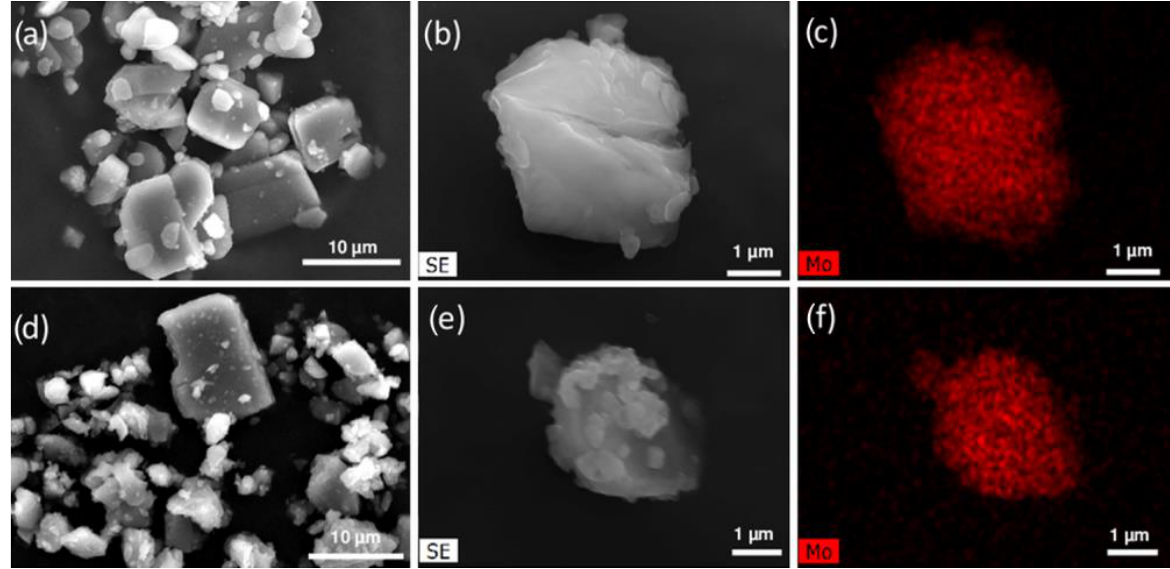
Figure 8. SEM images ( a , b , d , e ) and molybdenum maps ( c , f ) of 2 ( a – c ) and 2 -used ( d – f ) (Cy8/TBHP/TFT/70 °C).